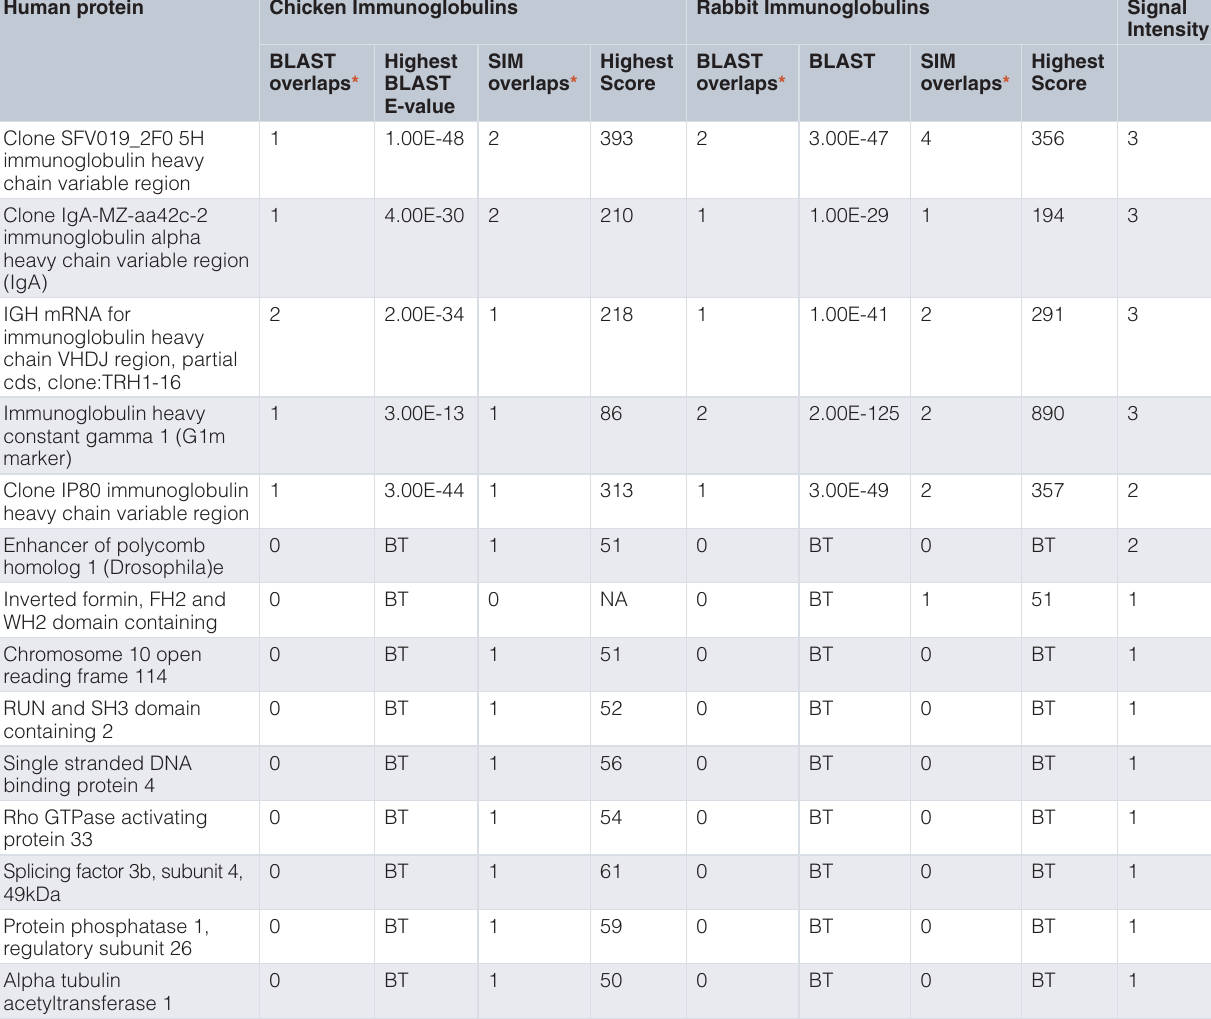
Table 5. In silico sequence similarity analysis between chicken IgY and rabbit IgG and array-identified human proteins. 14 most similar human proteins detected in this study, prioritised by sequence similarity. Human